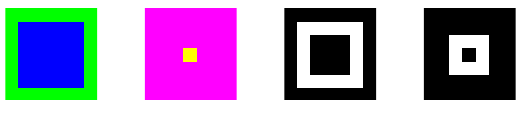
Fig. 4. From left to right: above: possible t-erosions of O and co ( O ), and the corresponding inner edge images, when using an ordering that is not compatible with complement co , below: the t-‘colour’ erosions of O and co ( O ), and their corresponding intern morphological gradients, using ≤ RGB .